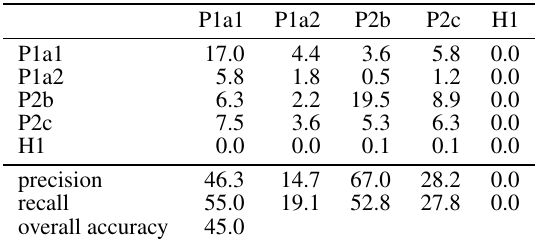
Table 3. Confusion matrix normalised by the number of pixels, precision, recall, and overall accuracy (%) of the U-net